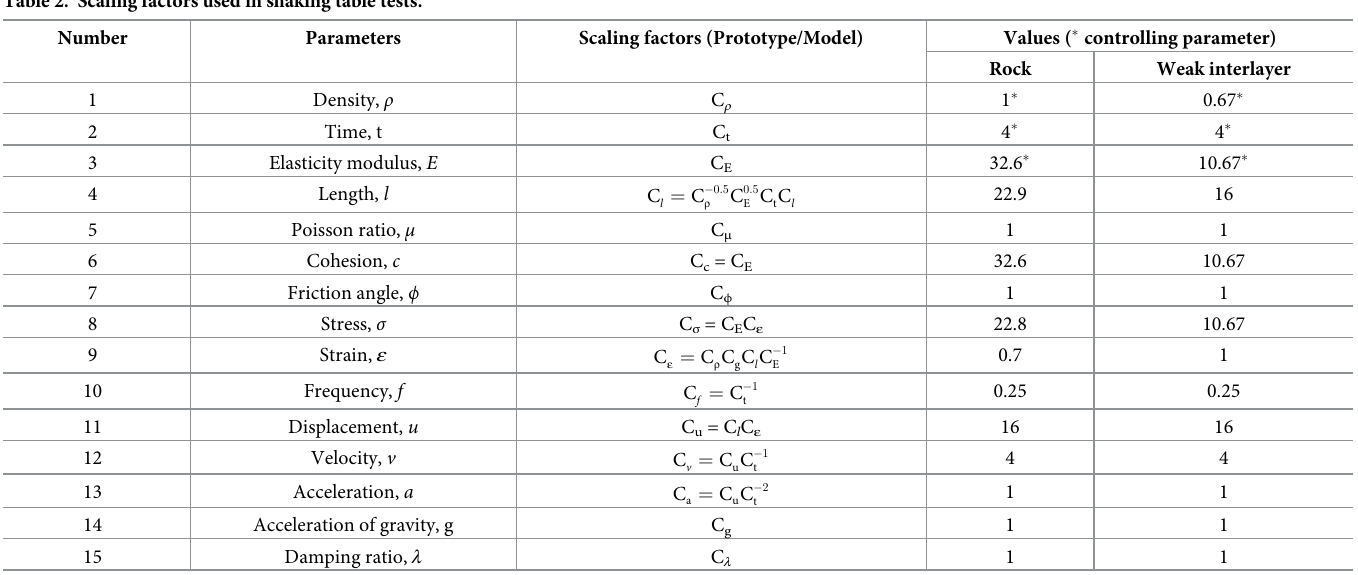
Table 2. Scaling factors used in shaking table